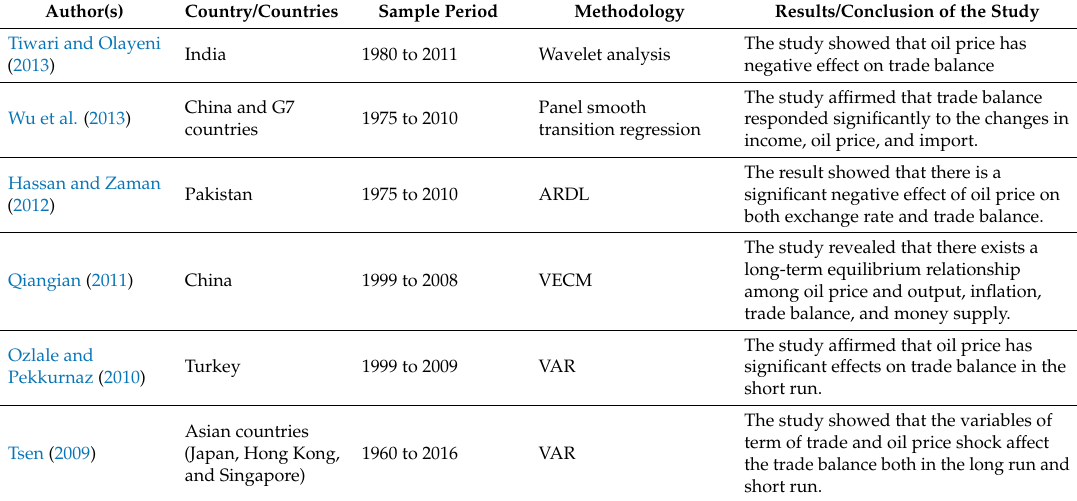
Table 2. Empirical evidence on oil price and trade